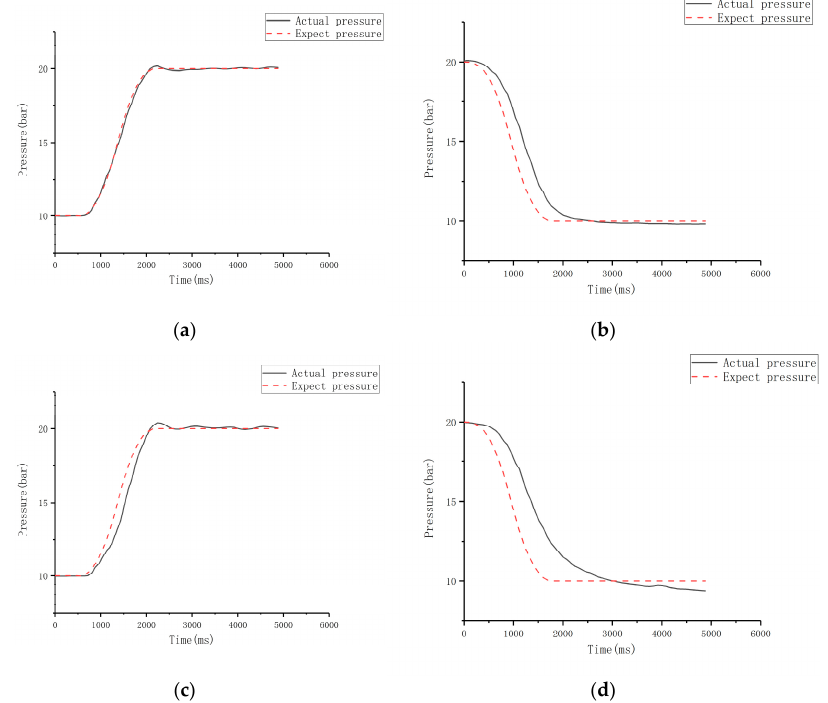
Figure 18. Pressure change curves when step signal changes from 10 bar to 20 bar and 20 bar to 10 bar. ( a ) Step rise curve of DTC based on sliding-mode control; ( b ) step descent curve of DTC based on sliding-mode control; ( c ) step rise pressure change curve of variable-speed pressure control; ( d ) variable-speed pressure control step-down pressure change curve. The pressure in the system when the given step signal changes from 30 bar to 50 bar